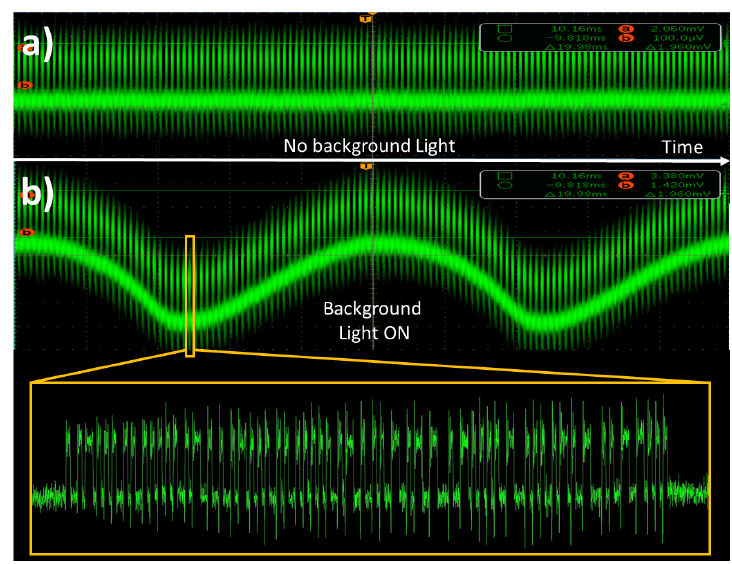
Figure 4. Example of OS after PD amplification with artificial lights off ( a ) and on ( b ), respectively.